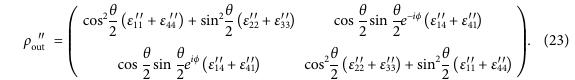
(cid:28) (cid:1)(cid:1) W ′ (cid:2) 1 − . The U ′ EAM